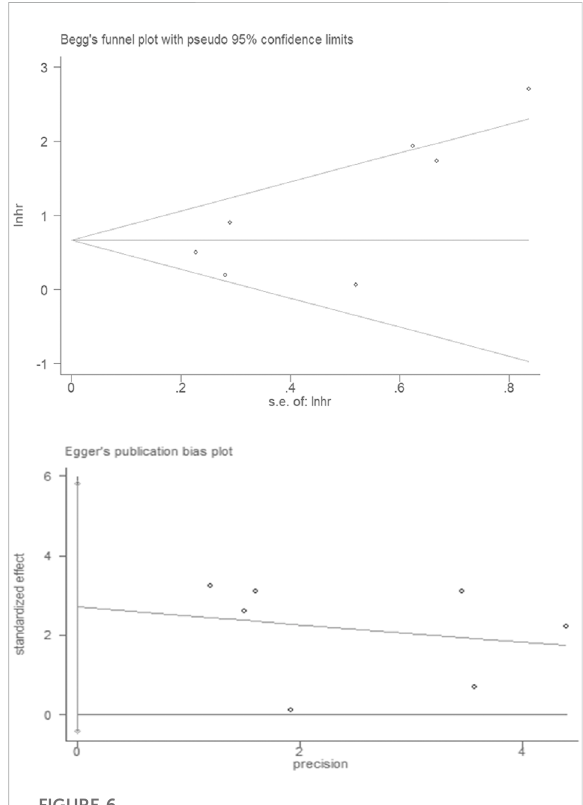
FIGURE 6 Publication bias in the enrolled studies. Publication bias was assessed using Begg ’ s funnel plots and Egger ’ s